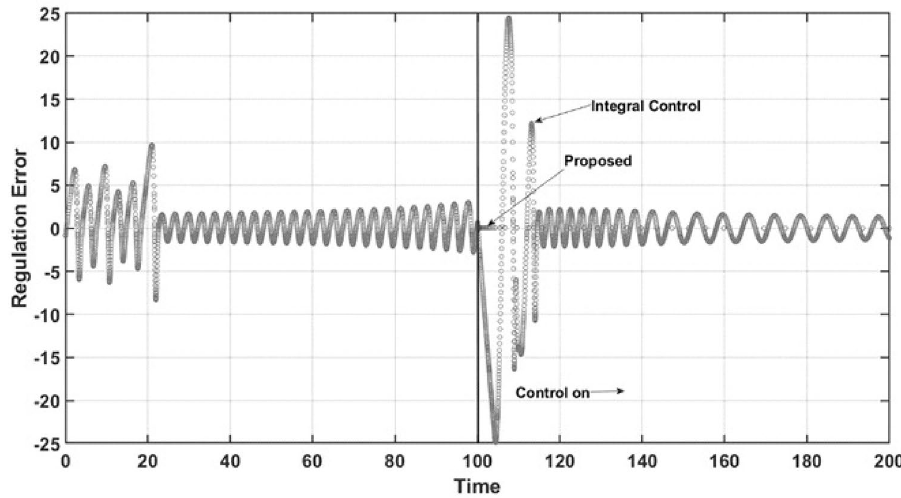
Figure 6. Regulation error.